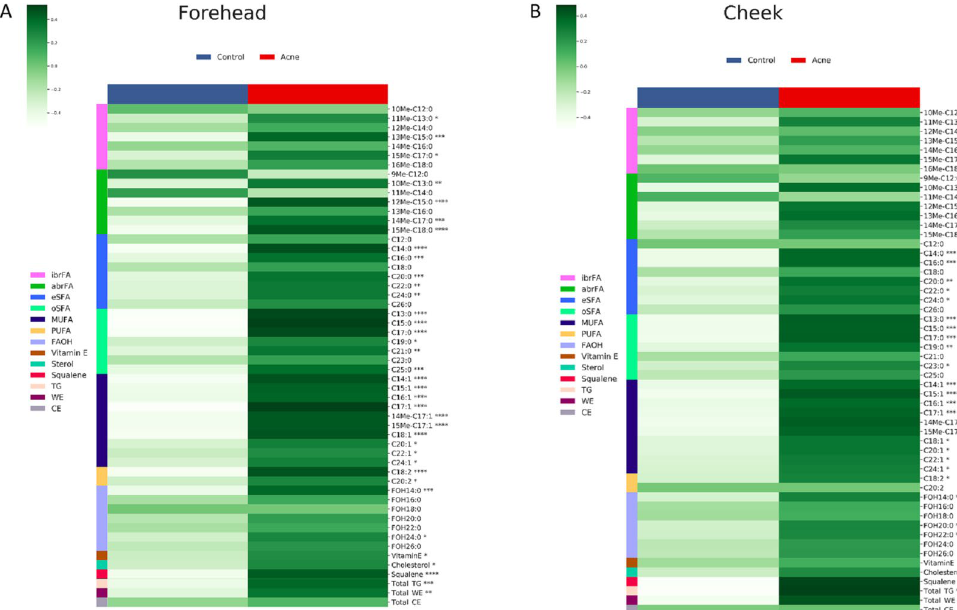
Figure 1. Heatmaps of amounts in µg of lipids quantified in sebum sampled with Sebutape patches on foreheads ( A ) and cheeks ( B ). Triglycerides (TGs), wax esters (WEs), and cholesterol esters (CEs) were quantified by HPTLC, whereas free fatty acids (FFAs), fatty alcohols (FOHs), squalene and cholesterol were quantified by GCMS. The total sebum amounts were obtained by summing the quantitative data obtained by HPTLC and GCMS. The heatmaps were generated by running custom Python code that uses the open source Matplotlib library. Significant differences were determined with Mann–Whitney test. *p ≤ 0.05, **p < 0.001, ***p < 0.005, ****p < 0.0001.